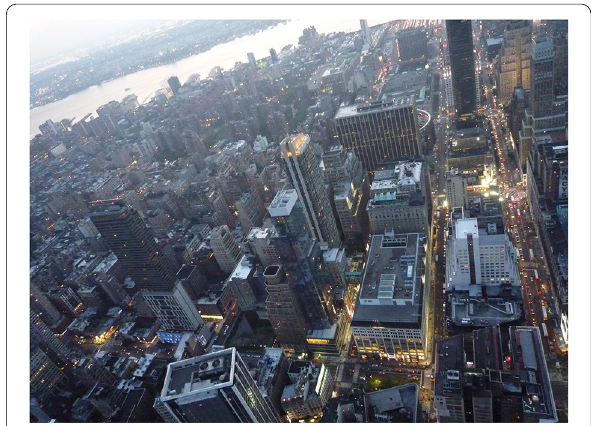
Fig. 1 The grid relates to the capitalist economy. Aerial view of New York. All photographs in this article are by co-author Juan Antonio